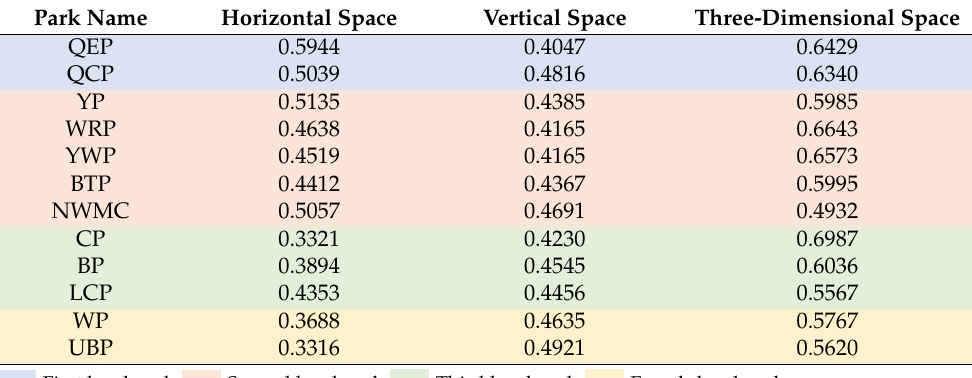
Table 4. Horizontal–vertical–three-dimensional spatial index calculation mean.